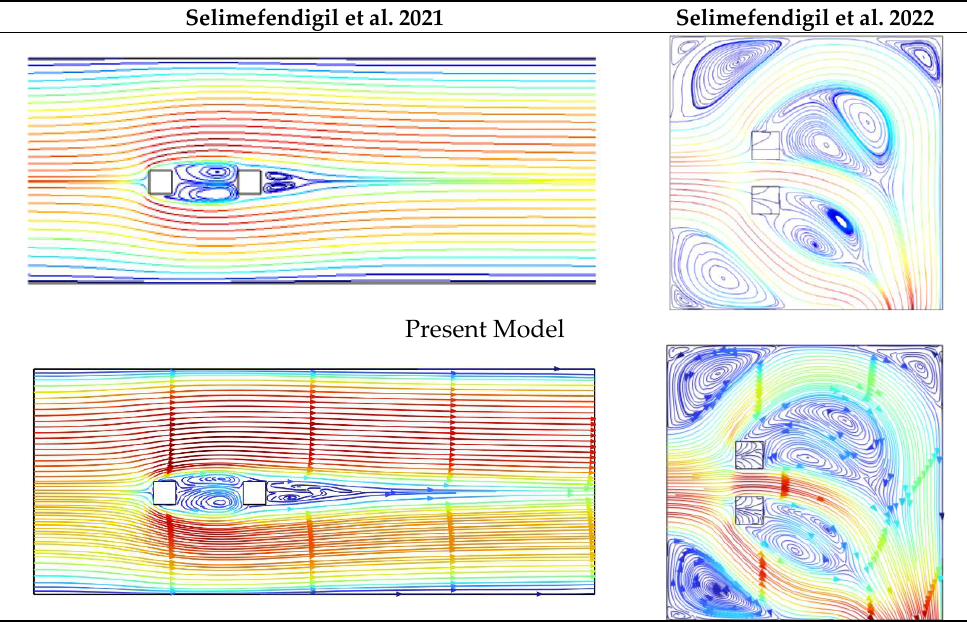
Table 4. Time step analysis for Case 3, u in = 3 m/s, and T in = 45 °C.